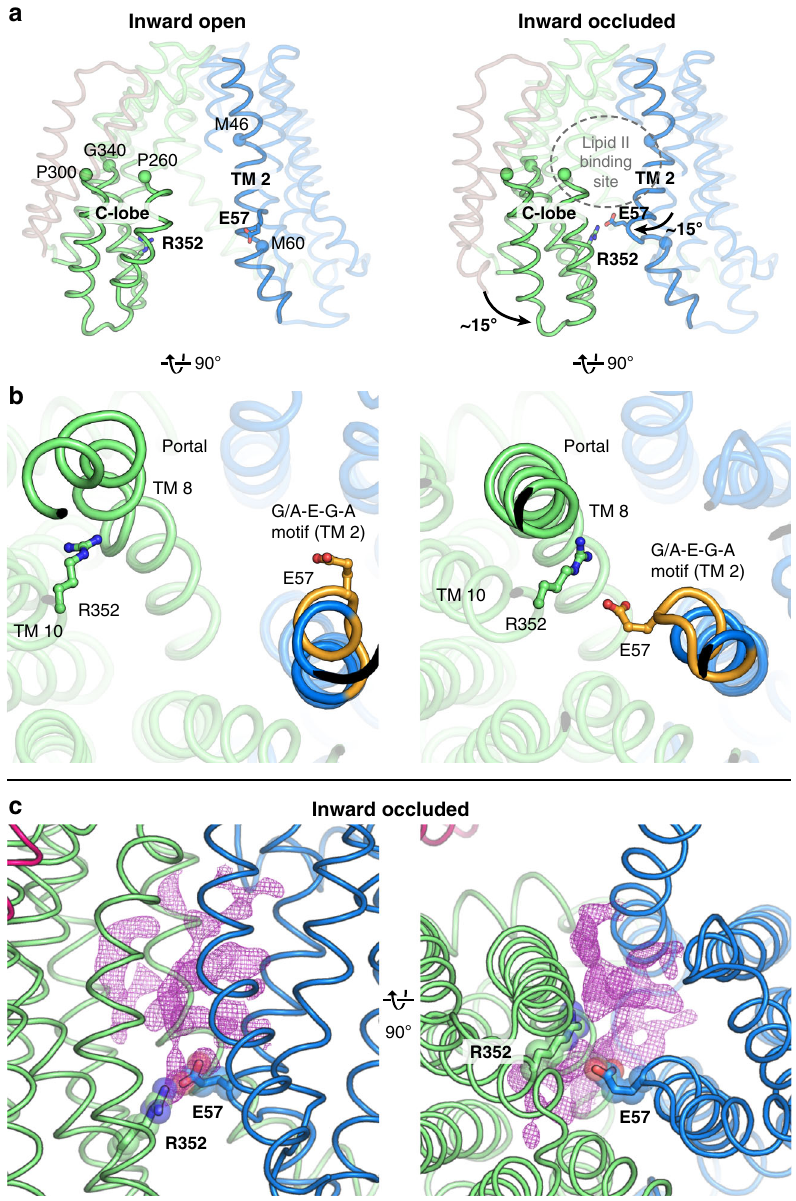
Fig. 3 The asymmetric inward-occluded conformation of MurJ TA . a Rotation of the cytoplasmic half of C-lobe by ~15° from the inward-open structure (left) to the inward-occluded structure (right). Conserved residues Pro260, Pro300, and Gly340 serve as hinges. At the same time, the middle segment of TM 2 also bends inwards by ~15°. Together these motions bring Glu57 (TM 2) and Arg352 (TM 10, Lys368 in E. coli MurJ) into proximity, which form a thin gate. Most of TM 1 is hidden for clarity. b The conserved (G/A)-E-G-A motif (orange) allows S-shaped bending of TM 2 by breaking the helix. TM 8 assumes a more α -helical geometry (albeit still not ideal) in the inward-occluded structure than in the other inward structures. c Unmodeled 2Fo − Fc electron density at the portal and transport cavity of the inward-occluded structure, displayed here as purple mesh contoured to 0.8